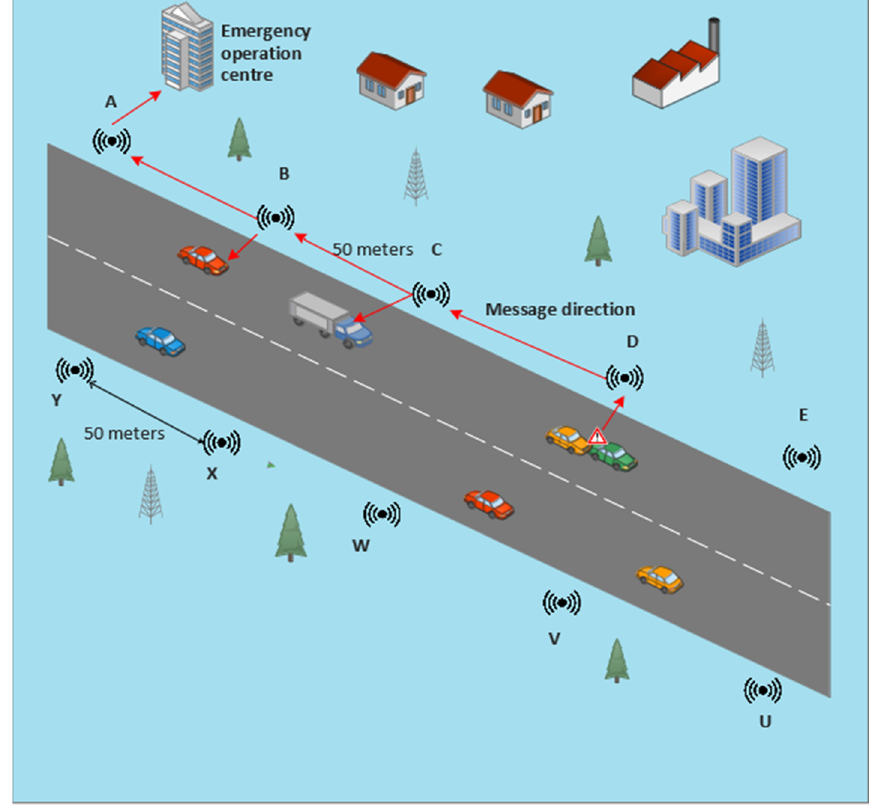
Figure 2. Illustration of a smart road.